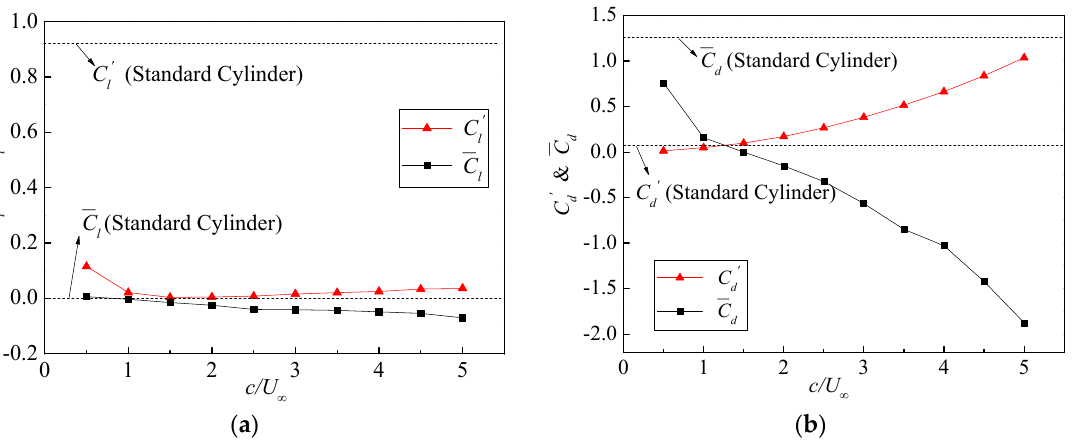
Figure 15. Characteristic values of lift and drag coefficient under different wave velocities. ( a ) C (cid:48) ' ( b ) C (cid:48) & C d d